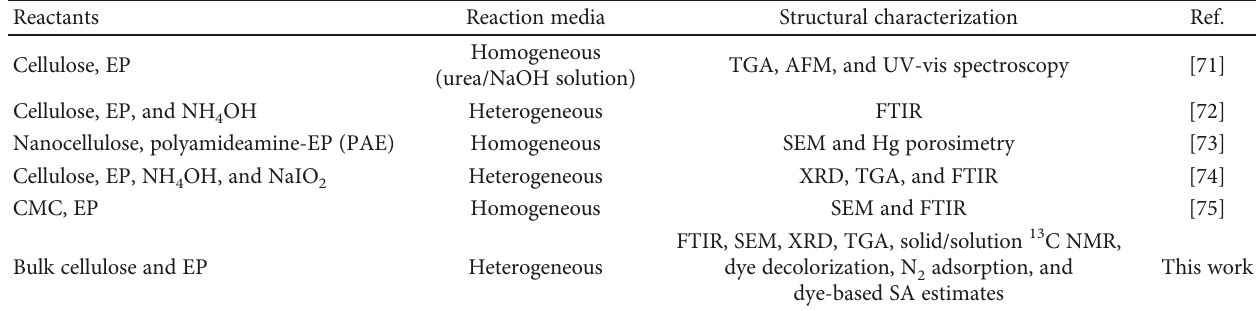
Table 3: Summary of studies for cross-linked cellulose